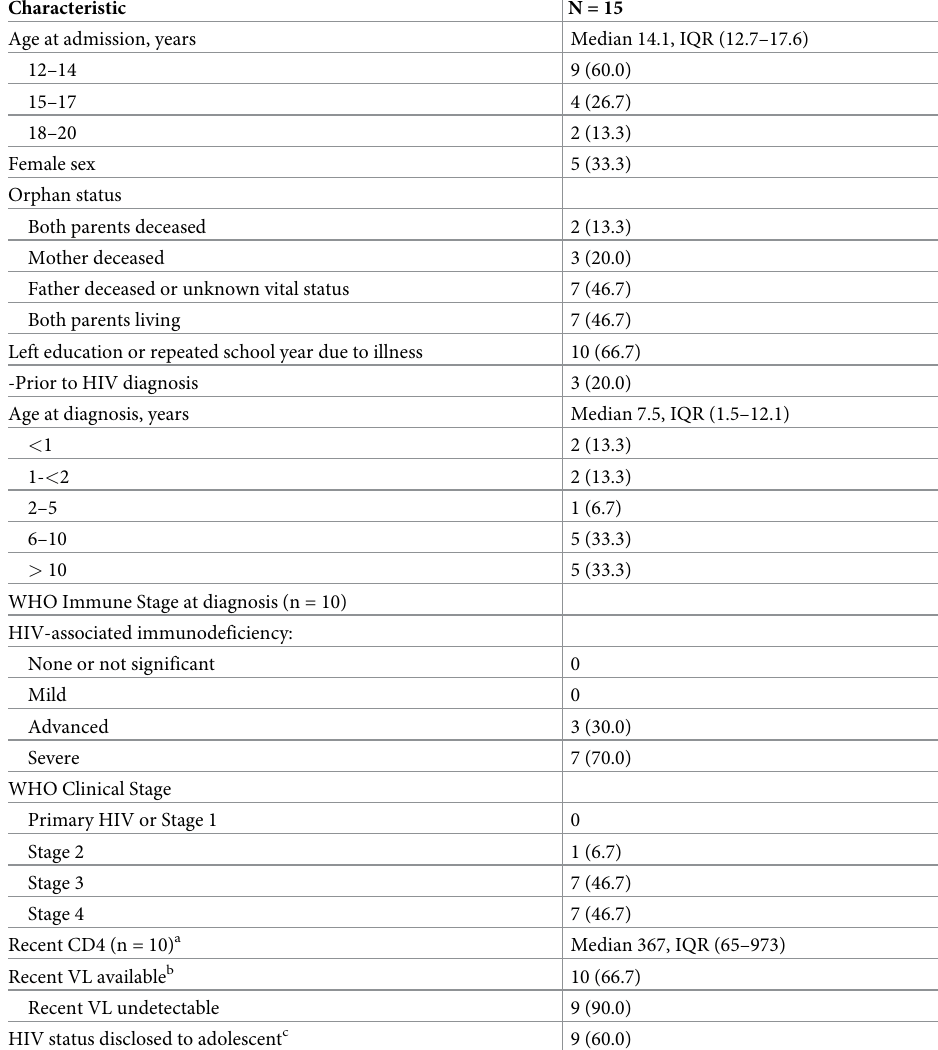
Table 1. Characteristics of enrolled